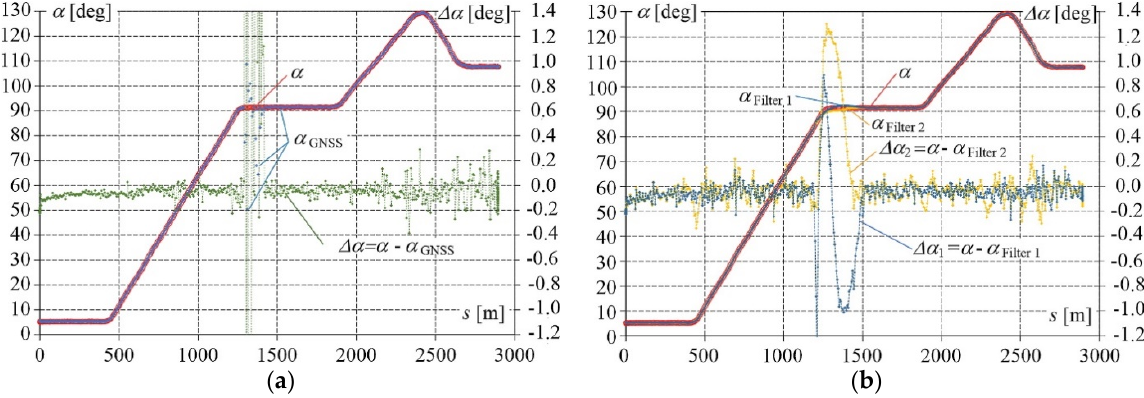
Figure 8. Results of direction angle measurement: ( a ) α GNSS —from GNSS and α — from INS, with angle difference Δ α = α − α GNSS ; ( b ) from GNSS after Whittaker filtering α Filter 1 and α Filter 2 and from INS α , with angle differences Δ α 1 = α − α Filter 1 and Δ α 2 = α − α Filter 2 .